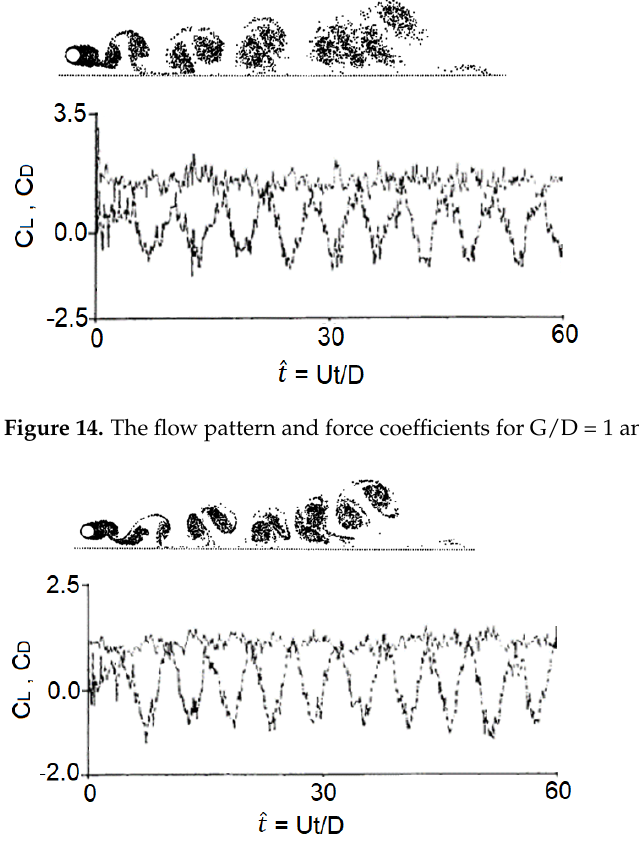
Figure 15. The flow pattern and force coefficients for G/D = 1 and Re = 10,000. The value of the Strouhal number is difficult to ascertain due to the numerical